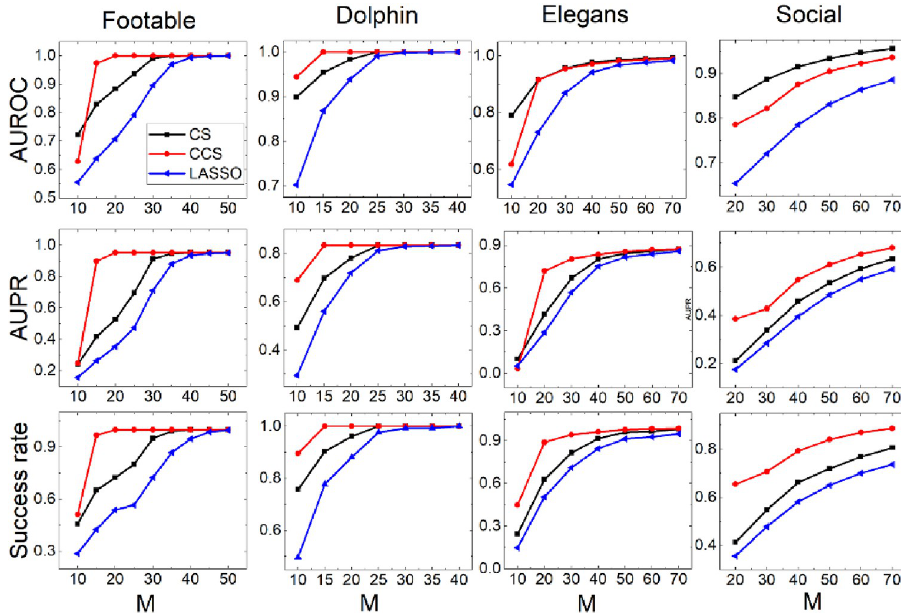
Fig 6. The performance of CCS, CS and LASSO is shown with three evaluation indexes on football, dolphin, elegans and social networks.